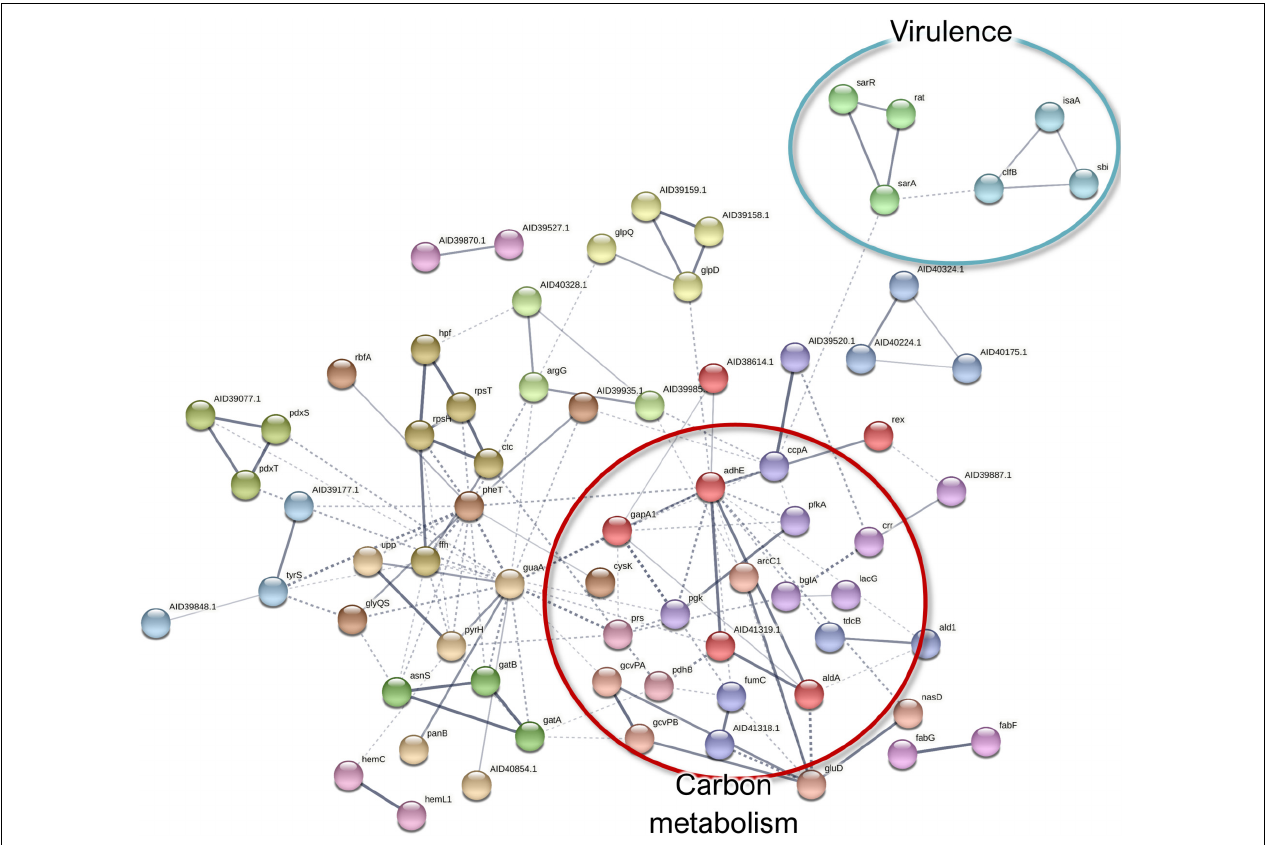
FIGURE 8 | A STRING database (Szklarczyk et al., 2019) network of interacting proteins with a significantly lower abundance in Staphylococcus aureus co-culture versus monoculture exoproteome.